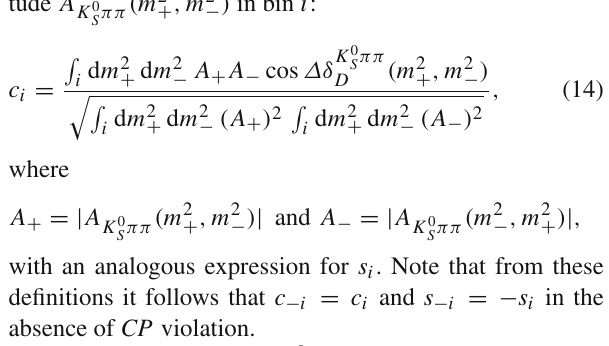
( m 2 , m 2 ) in bin i + −